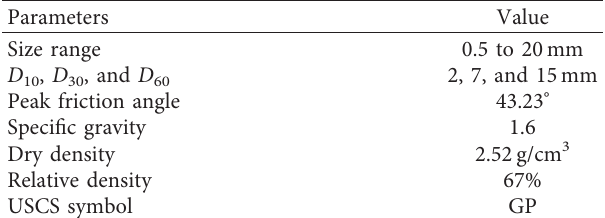
Table 3: Properties of aggregates.